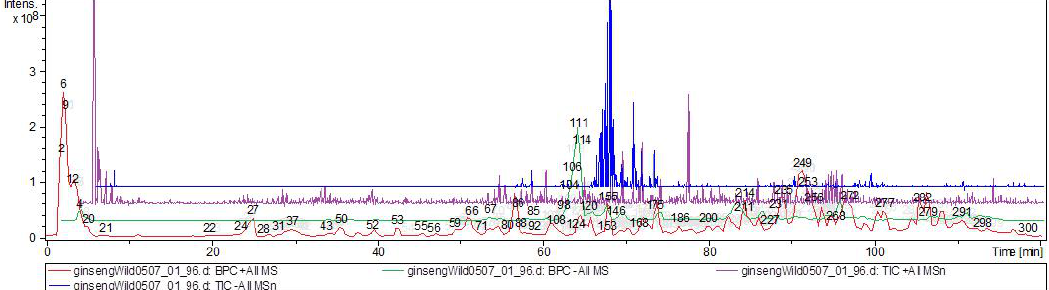
Figure 6. Representative chemical profiles of the wild ginseng’s (Russia) total ion chromatogram from the supercritical CO 2 extract.